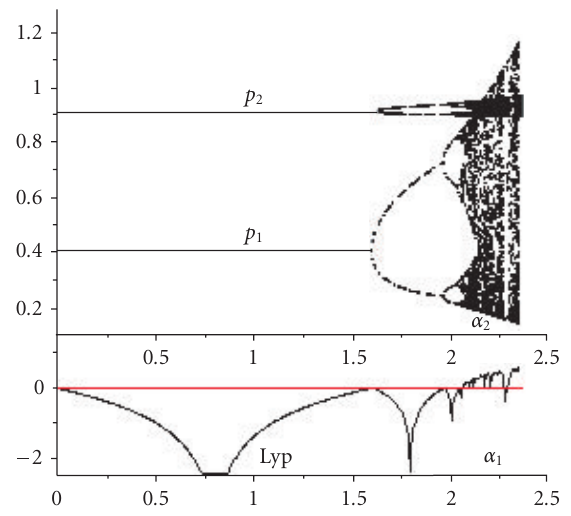
Figure 4.3 . Bifurcation diagram for α 2 = 0 .